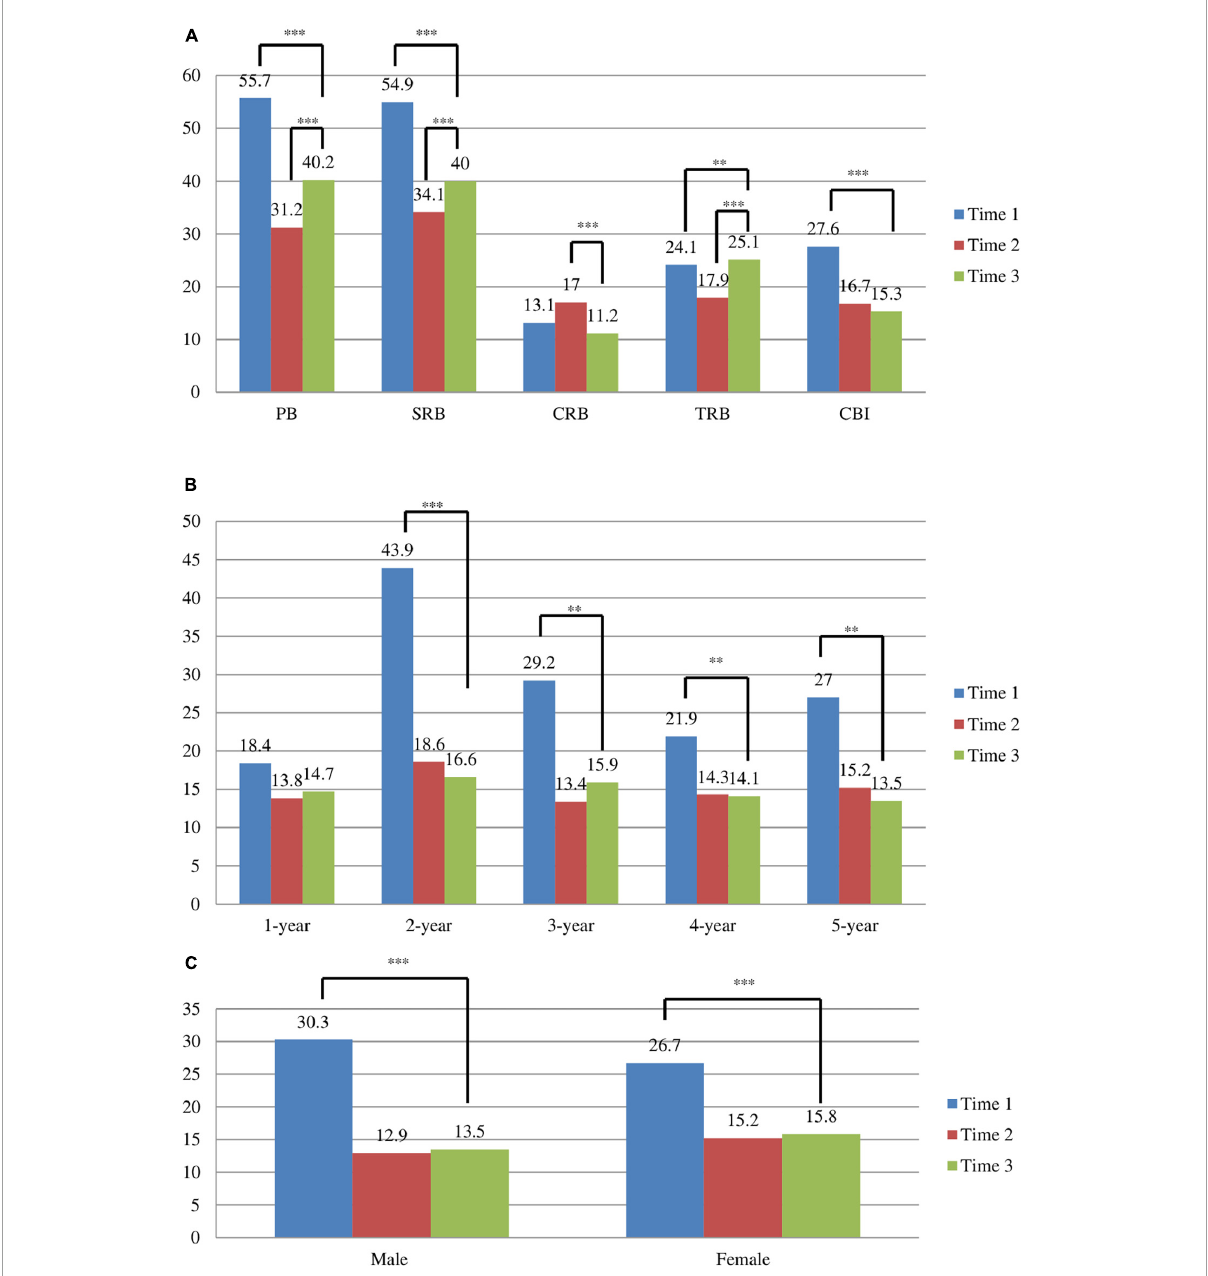
FIGURE1 The prevalence of burnout and CBI mean scores before OL (Time 1), in initial period of online learning (OL) (Time 2) and after 1 year of OL (Time 3) caused by the COVID-19 pandemic distributed by: (A) CBI dimensions; (B) years of study; (C) gender. Data on burnout prevalence in Time 1 and Time 2 based on previous research (Bolatov et al., 2021a). ∗∗ p < 0.05, ∗∗∗ p < 0.001.